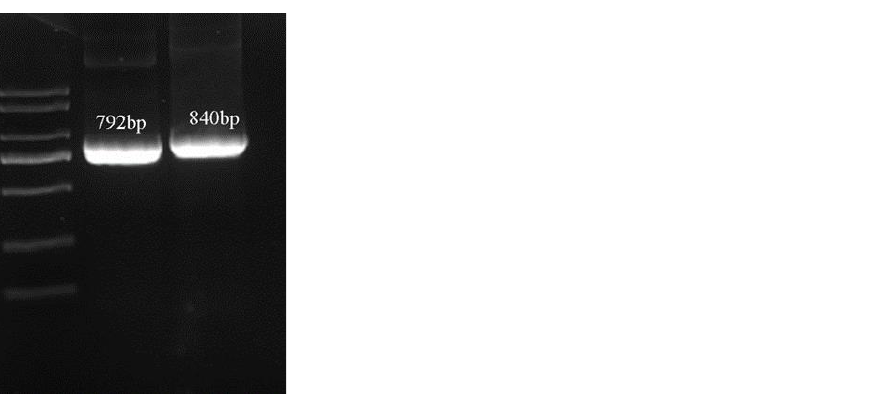
Figure 1. The PCR amplification products of the ORF sequences of HbOT1 and HbOT2 . Marker DL2000.